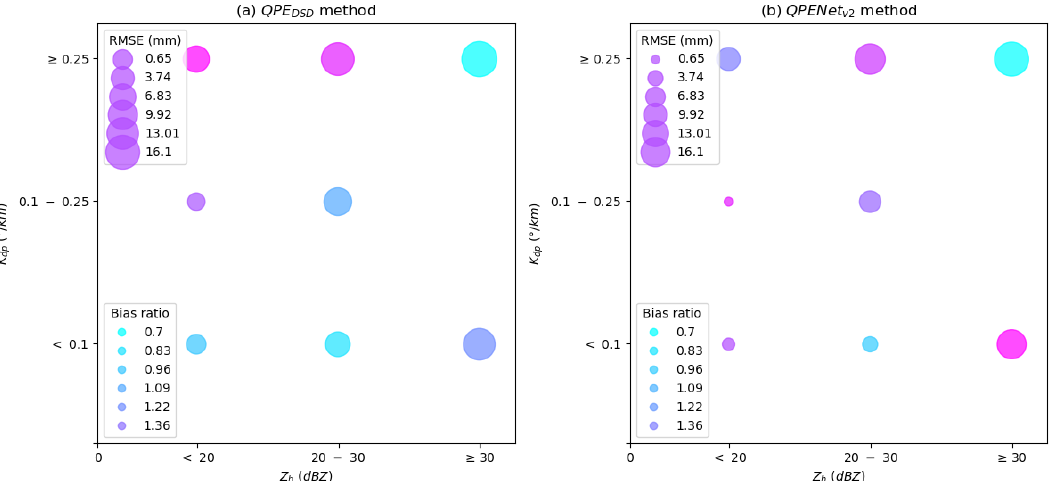
Figure 10. Bubble charts of the bias ratios and RMSEs of the radar-derived hourly rainfall estimates during typhoon Merbok: ( a ) QPE DSD ; ( b ) QPENet V2 . The bias ratios and RMSEs were calculated for different Z H and K DP ranges using observations from the automatic weather stations as references. Z H is divided into “<20 dBZ”, “20–30 dBZ”, and “ ≥ 30 dBZ”. K DP is divided into “<0.1 ◦ · km − 1 ”, “0.1 − 0.25 ◦ · km − 1 ”, and “ ≥ 0.25 ◦ · km − 1 ”. The size of the dots represents the RMSE, the color of the dots indicates the bias ratio.